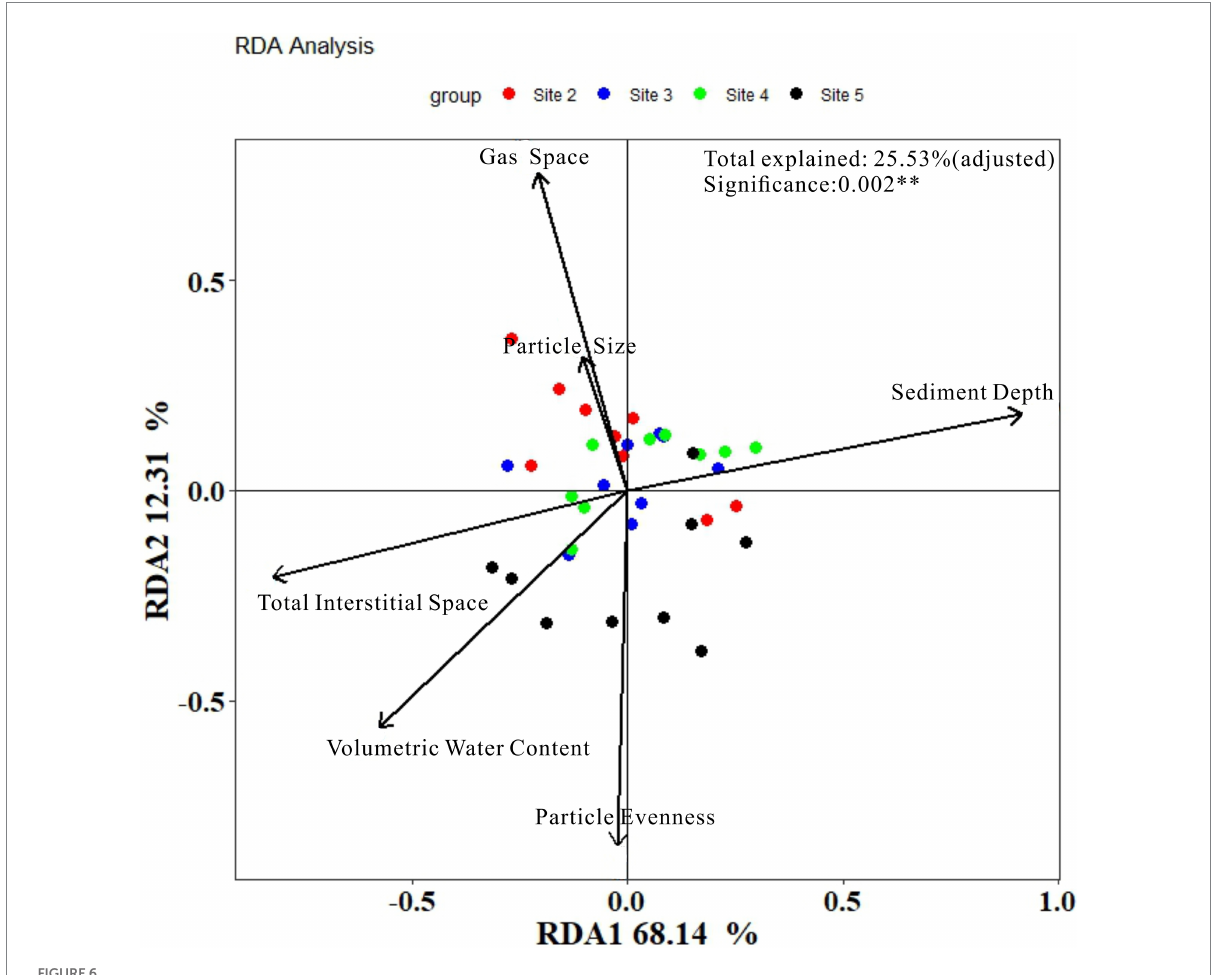
FIGURE 6 Results of RDA